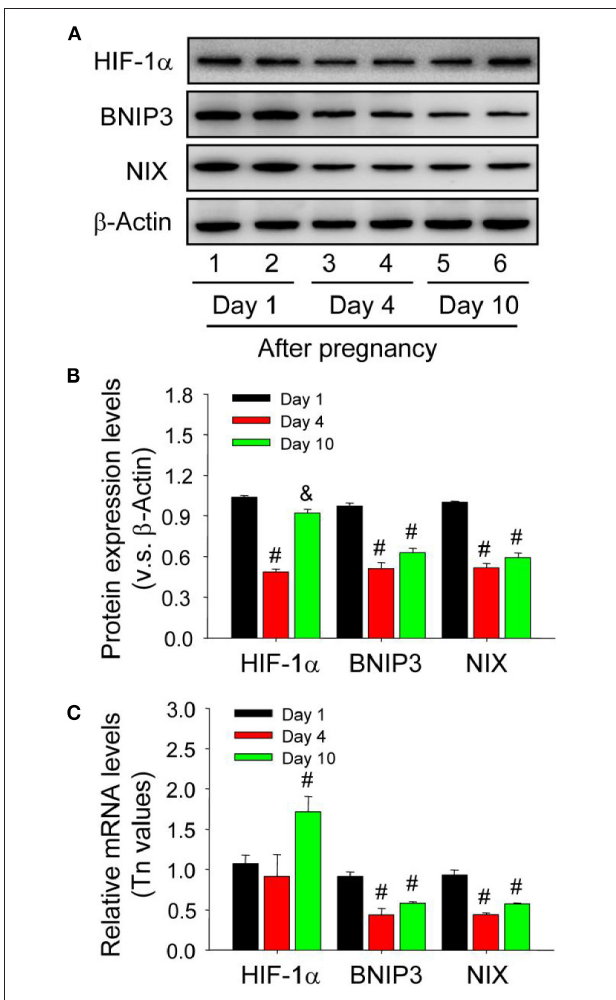
FIGURE 10 | Expression changes of HIF-1 α /BNIP3/NIX proteins in the luteal cells during the development of corpus luteum. (A) Expression changes of HIF-1 α , BNIP3, and NIX proteins in luteal cells during the development of corpus luteum (from Day 1 to 10). (B) Summarized intensities of HIF-1 α , BNIP3, and NIX bloting normalized to the control (Day 1). (C) Expression changes of HIF-1 α , BNIP3, and NIX mRNA in the luteal cells during the development of corpus luteum. The luteal cells were obtained from the pregnant corpus luteum on Day 1, 4, and 10. Each value represents the mean ± SE. One-way analysis of variance (ANOVA) was used to analyze the data, followed by a Tukey’s multiple range test. n = 6. # P < 0.05, vs. the group in black. & P < 0.05, vs. the group in